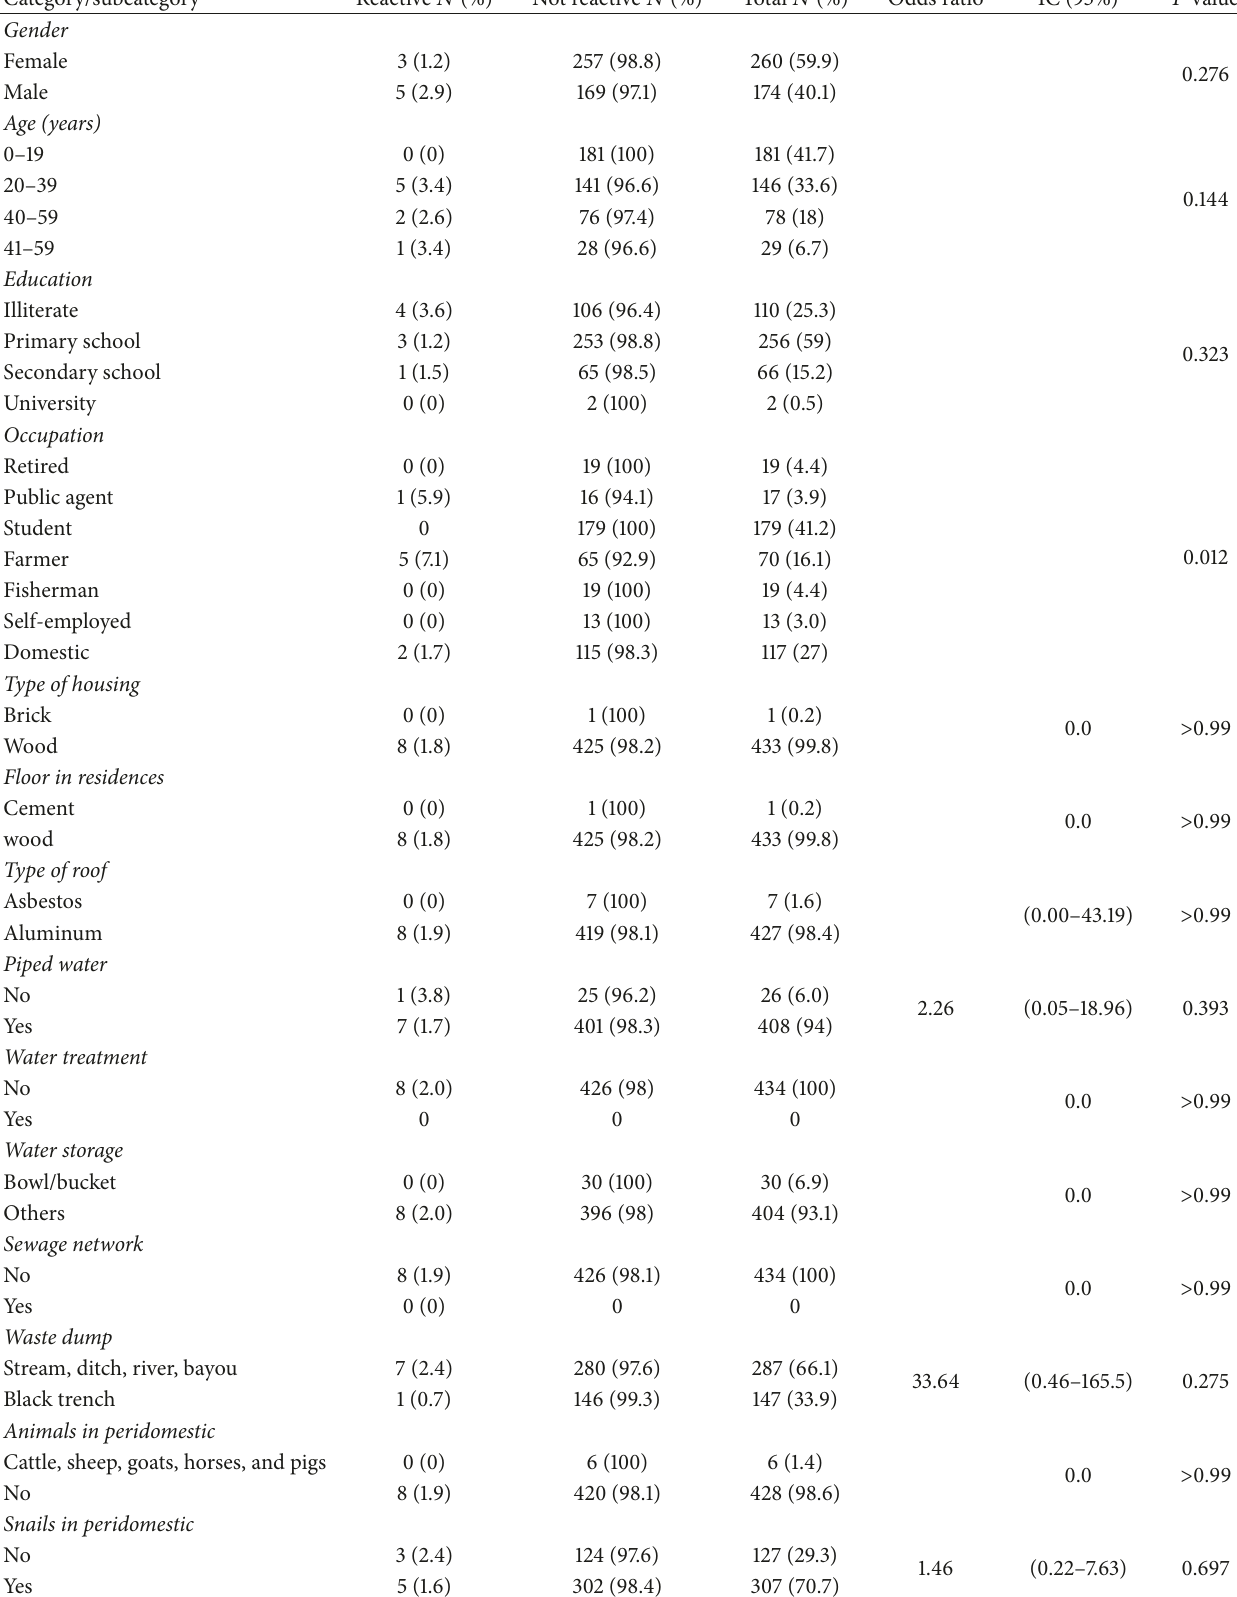
Table 1: Demographic and socioeconomic characteristics in the study